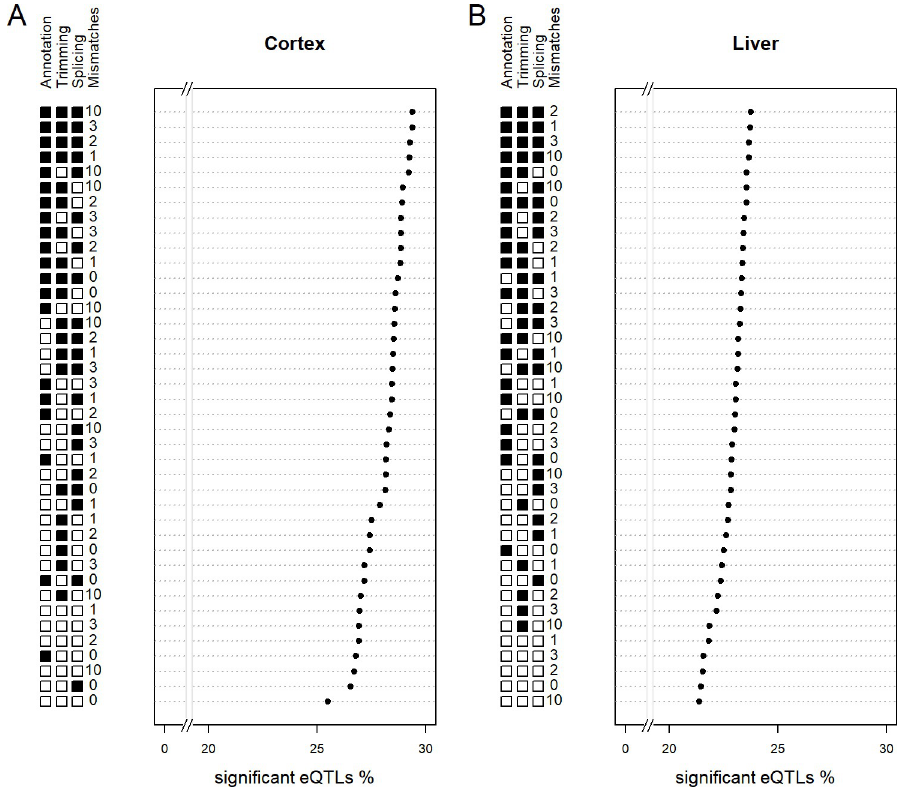
Fig 5. Evaluating mapping parameters. A. The performance on local eQTLs of selected mapping settings on cortex samples (average of the NSD and SD conditions) is measured by the percentage of expressed genes that have a significant local eQTL. The BXD-specific references were used. C. As in A but for liver samples.